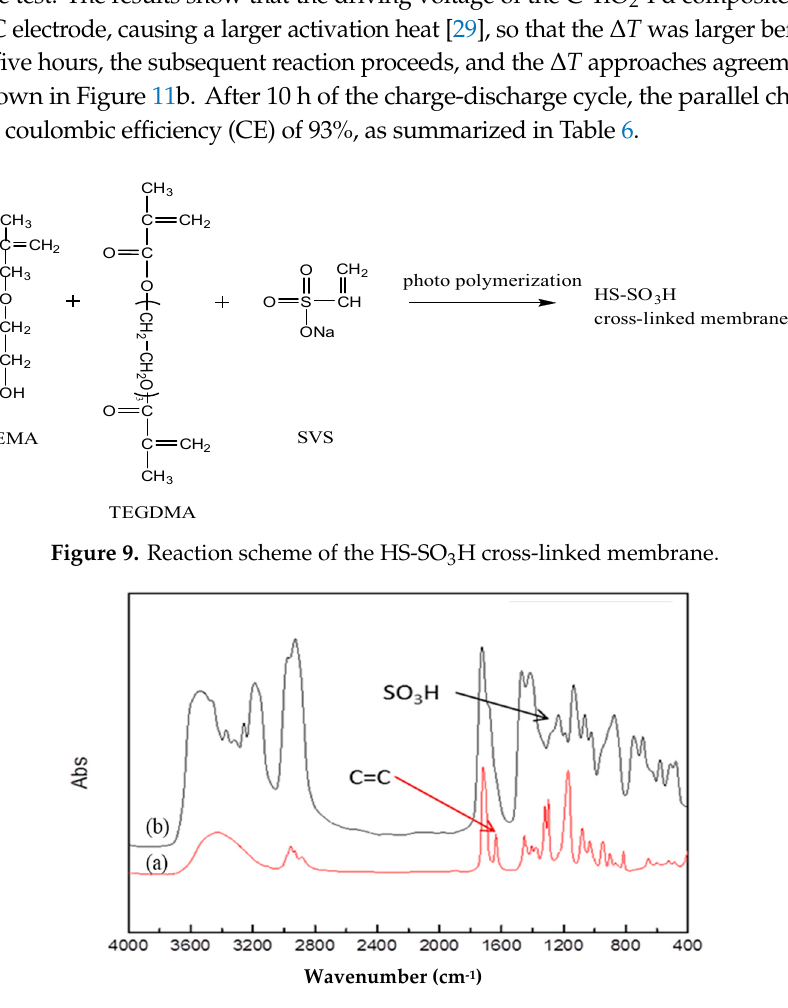
Figure 10. FT-IR spectra of ( a ) hydroxyethylmethacrylate (HEMA) monomer ( b ) HS-SO 3 H membrane.